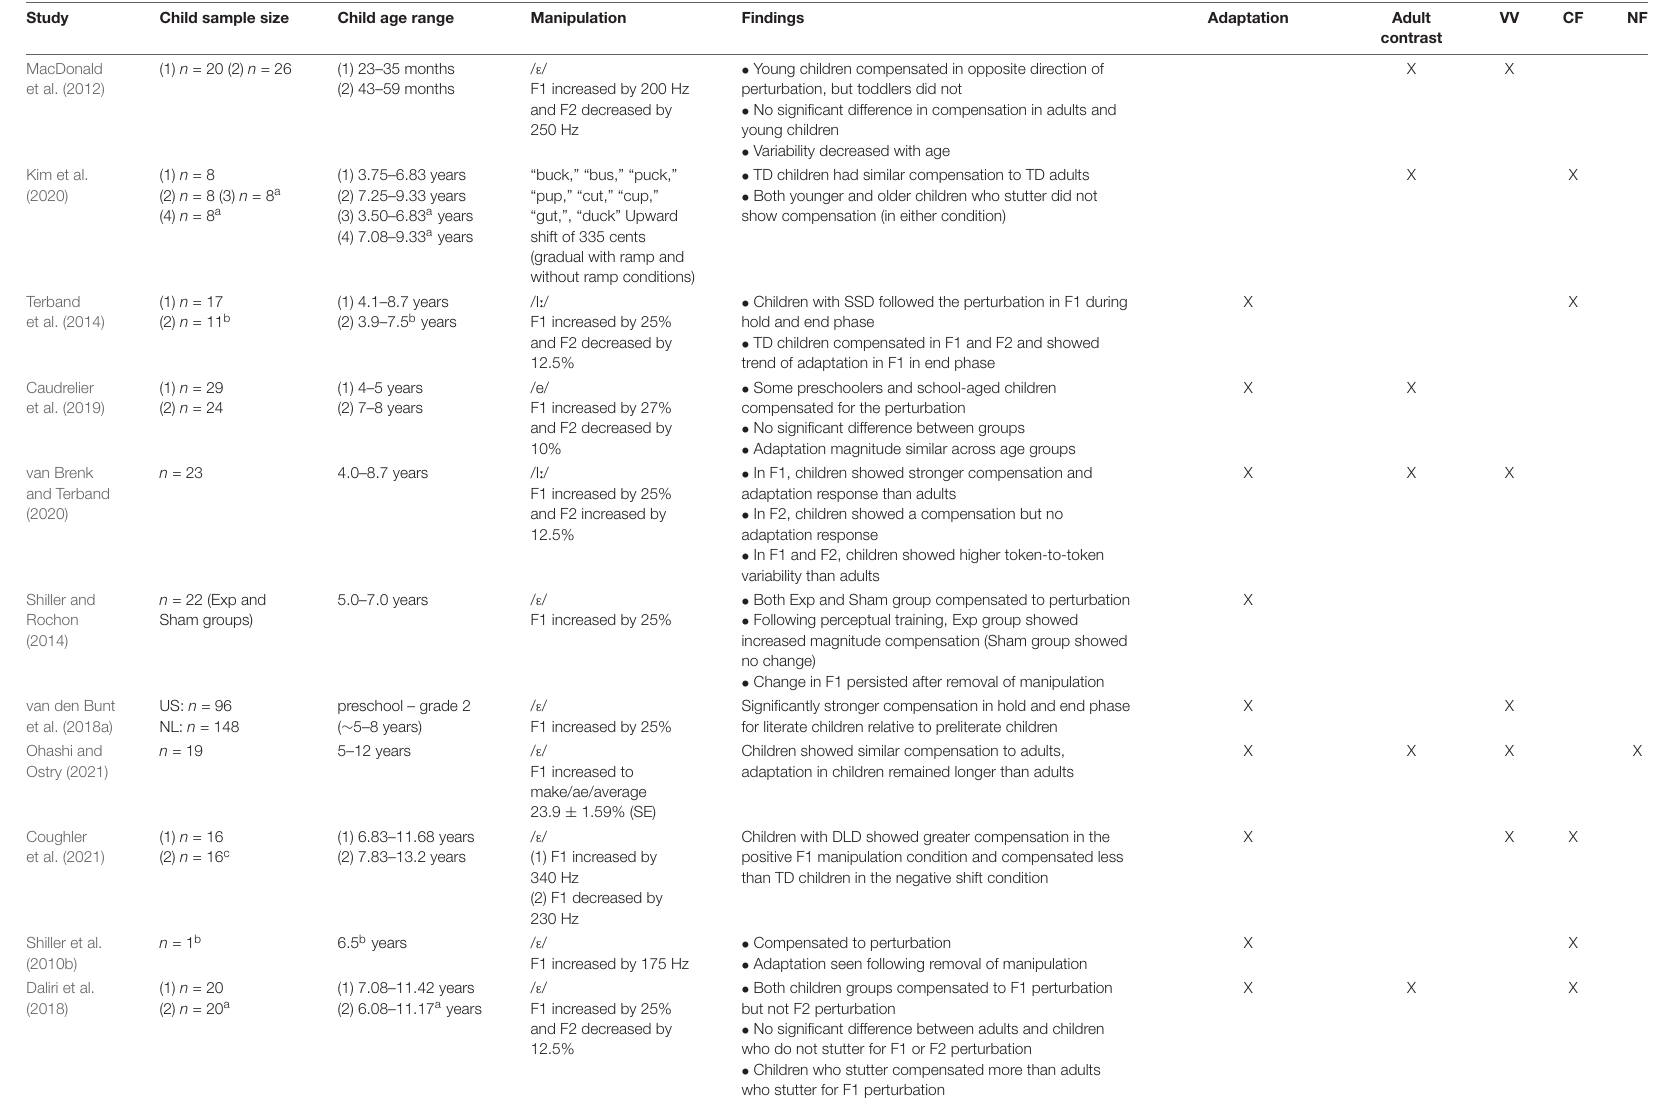
TABLE 2 | Behavioral findings in response to formant manipulated altered auditory feedback in typically developing (TD) children and children with speech and language